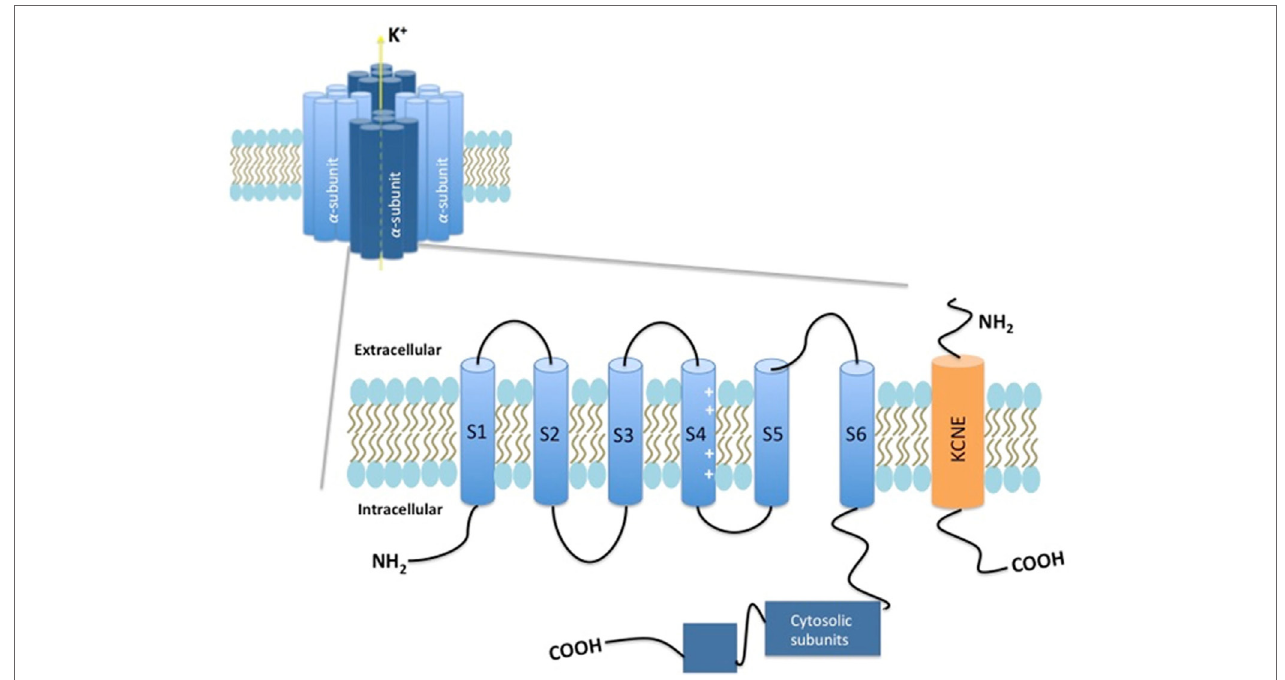
FiGURe 1 | Schematic presentation of the Kv7